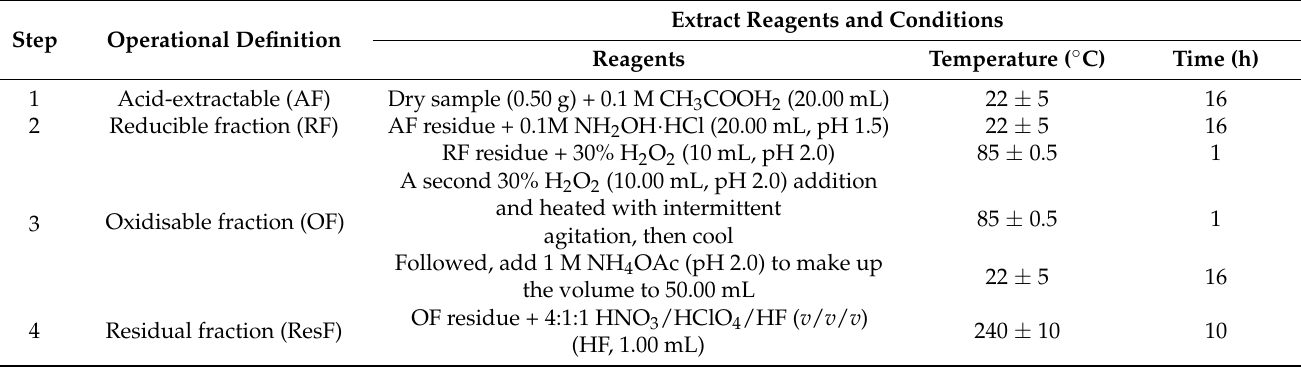
Table 3. Analytical conditions for the modified BCR sequential extraction